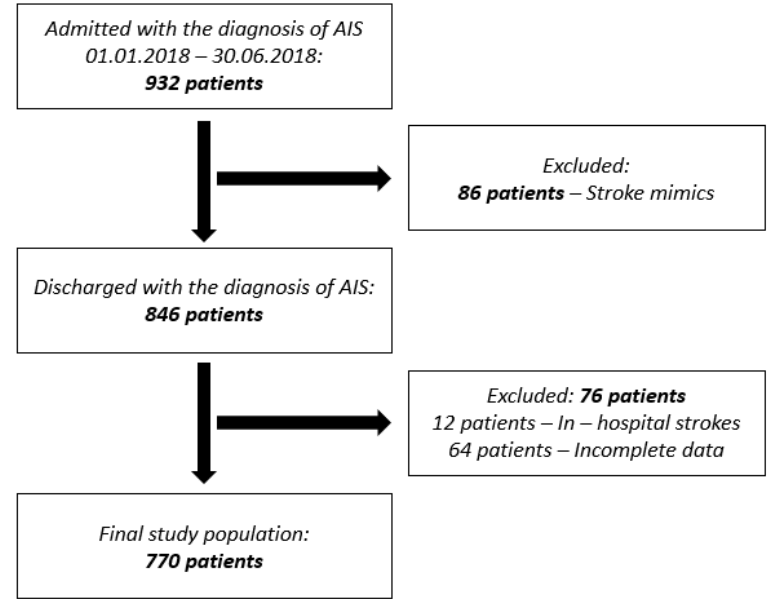
Figure 1. Flowchart of the study population. ( AIS: acute ischemic stroke )